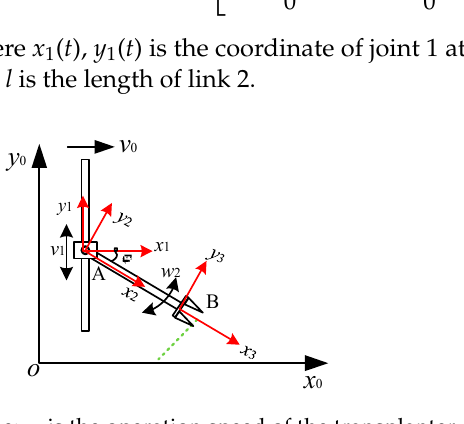
Figure 3. Mathematical model of transplanting robot arm.